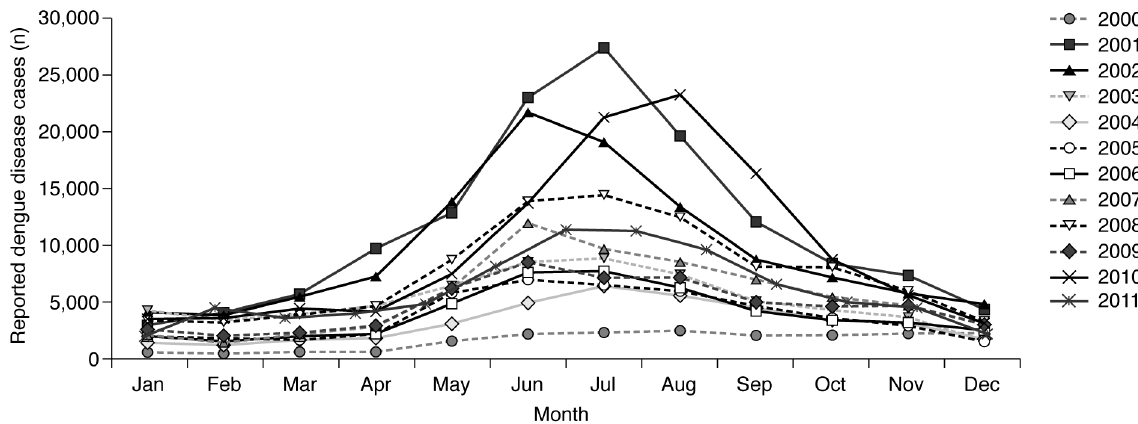
Figure 6. Number of reported cases due to dengue disease, by month, Thailand, 2000–2012 [23–34]. Most of Thailand has a tropical wet and dry or savannah climate, where the wettest months are usually August–October. Country-wide, average annual temperatures range from 19 u C to 38 u C, with higher temperatures in the dry season (November to March). The available data show a seasonal peak in the numbers of cases due to dengue between May and September reflecting seasonal changes in climate and the association between the wettest months and vector activity.